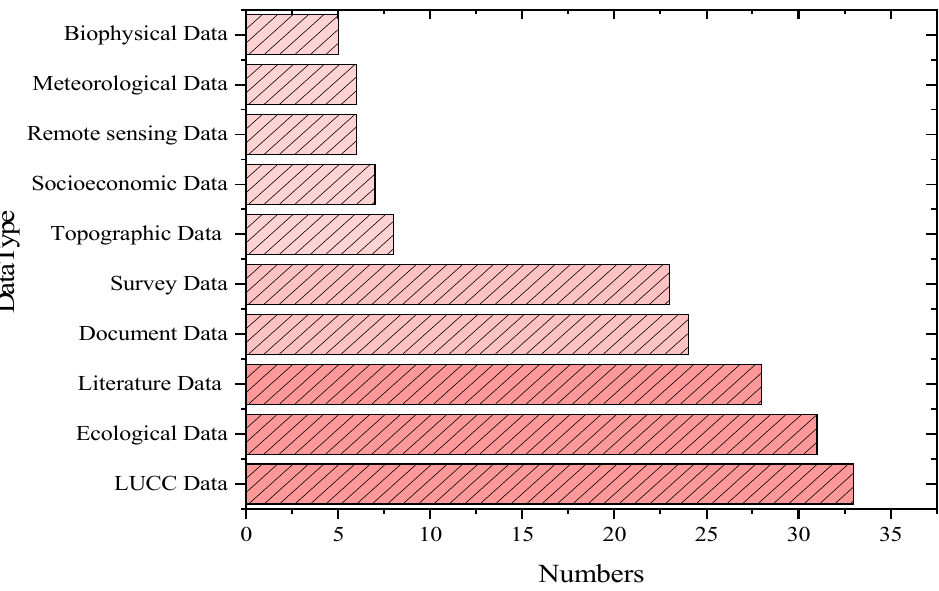
Figure 11. Data types used in the selected articles. The x -axis represents the number of different data types. Table 2. Abstract strategic methods from a macro qualitative